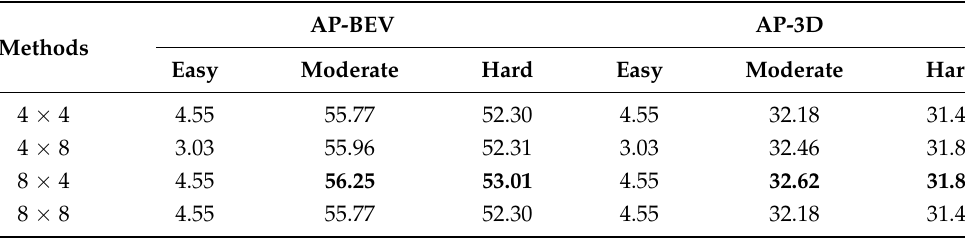
Table 6. Performance of the object detection for different subcategory